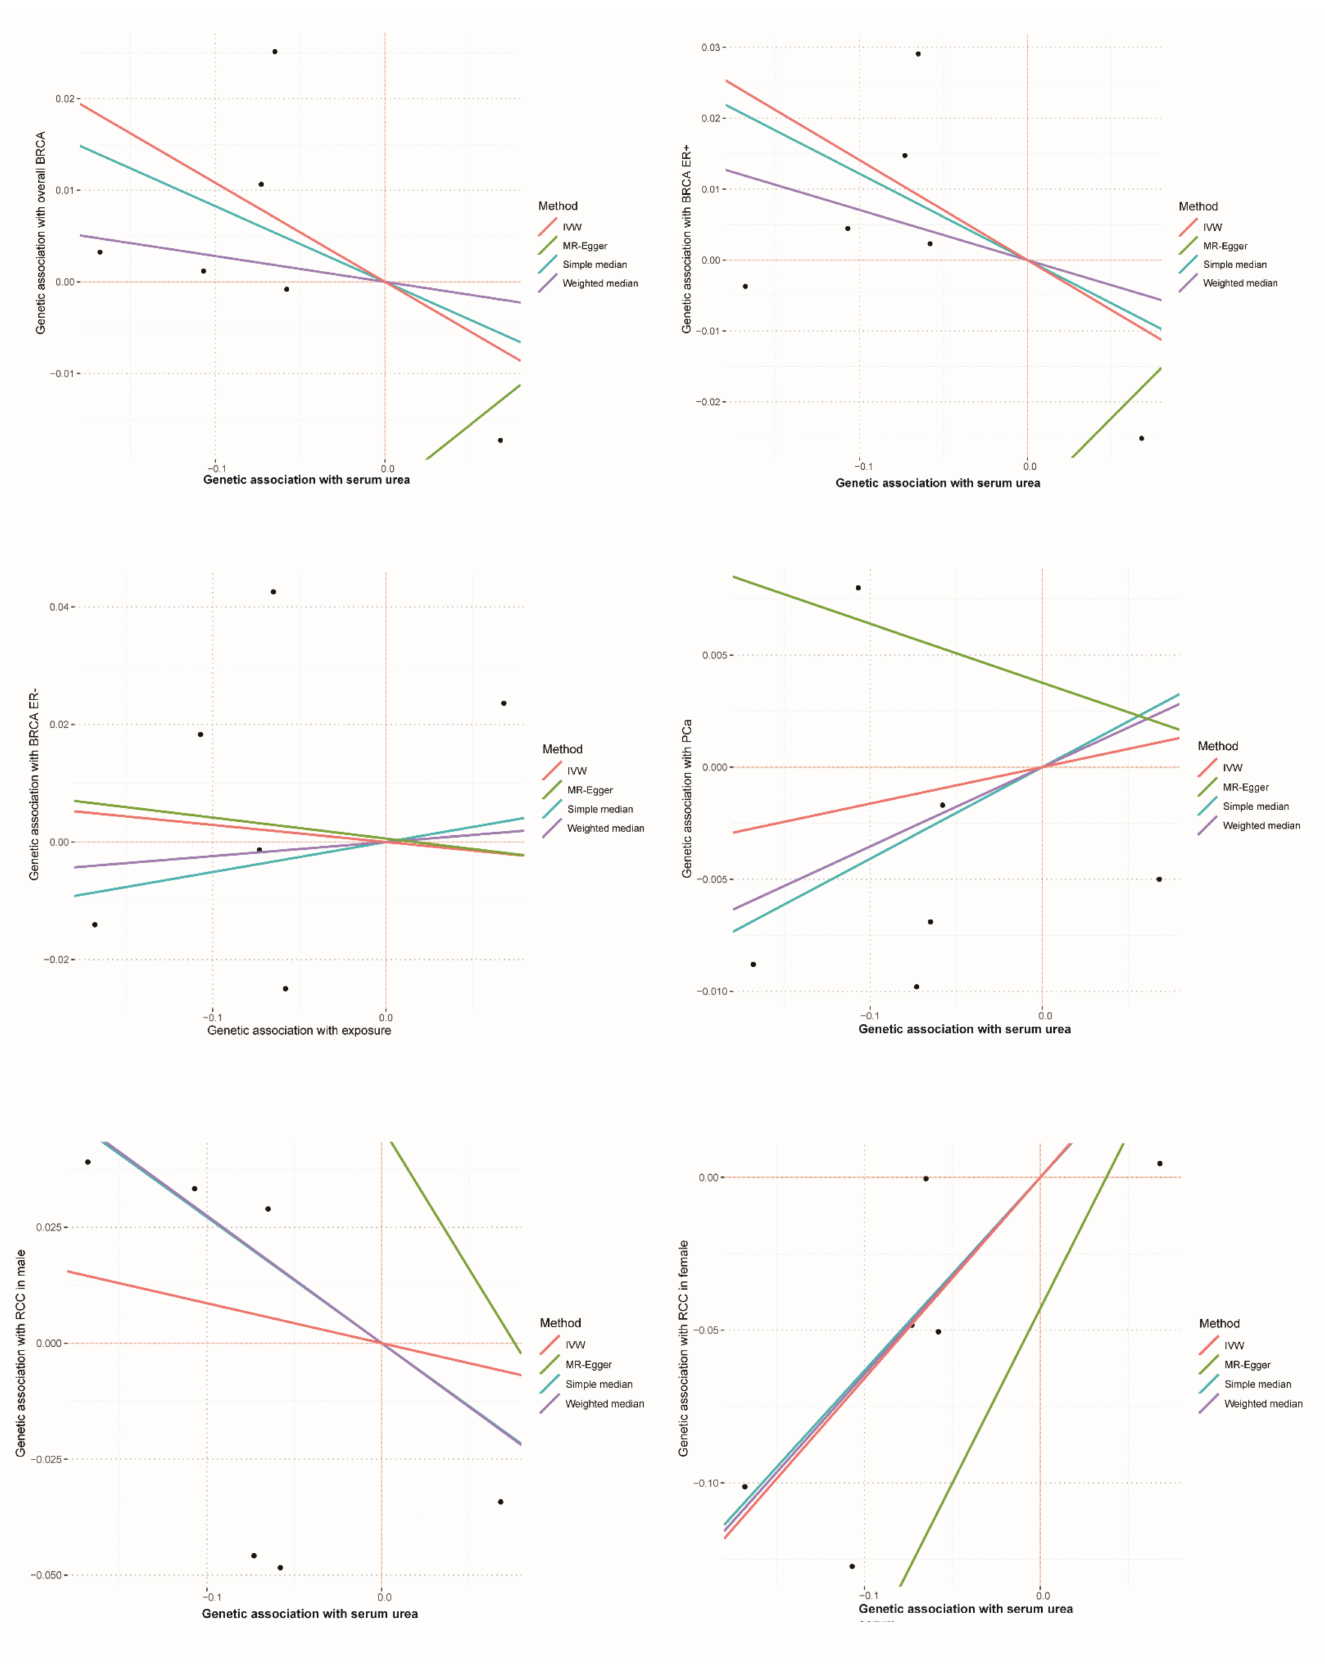
Figure 3. Scatter plots of genetics associated with cancer plotted against genetics associated with serum urea. The estimates for six SNPs on overall BRCA, BRCA ER+, BRCA ER − , PCa, RCC in male and RCC in females were